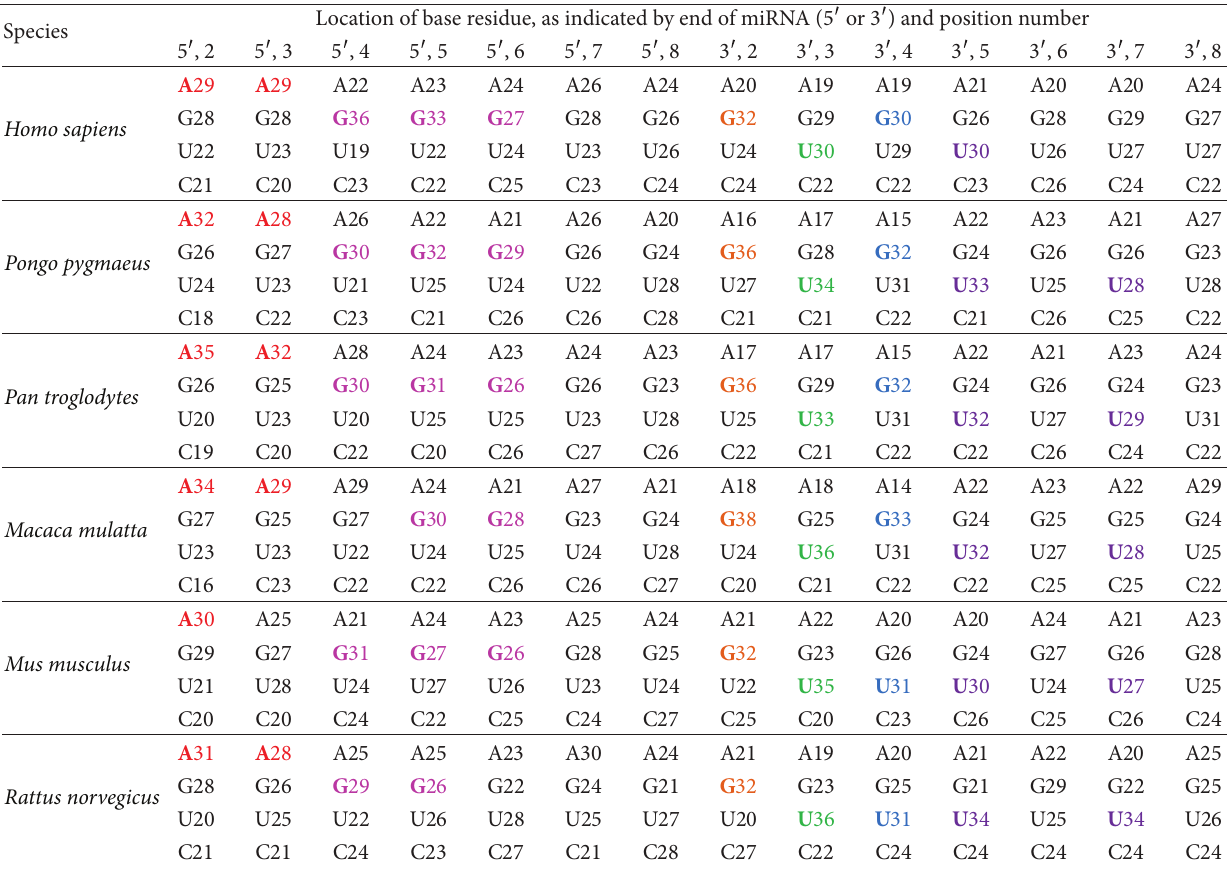
Table 2: Percentages (%) of A, G, U, and C in every mature miRNA of each species studied. This table contains base composition information for the second-through-eighth nucleotides from both ends of the miRNAs. Bases shown in red are the most favored residues at positions 2 and 3 of the 5 󸀠 end; bases in magenta are the most favored residues at positions 4–6 of the 5 󸀠 end; bases in orange are the most favored residues at position 2 of the 3 󸀠 end; bases in green are the most favored residues at position 3 of the 3 󸀠 end; bases in blue are the most favored residues at position 4 of the 3 󸀠 end; and bases in purple are the most favored residues at positions 5 and 7 of the 3 󸀠 end of the miRNAs examined. Location of base residue, as indicated by end of miRNA ( 5 or 3 ) and position Species